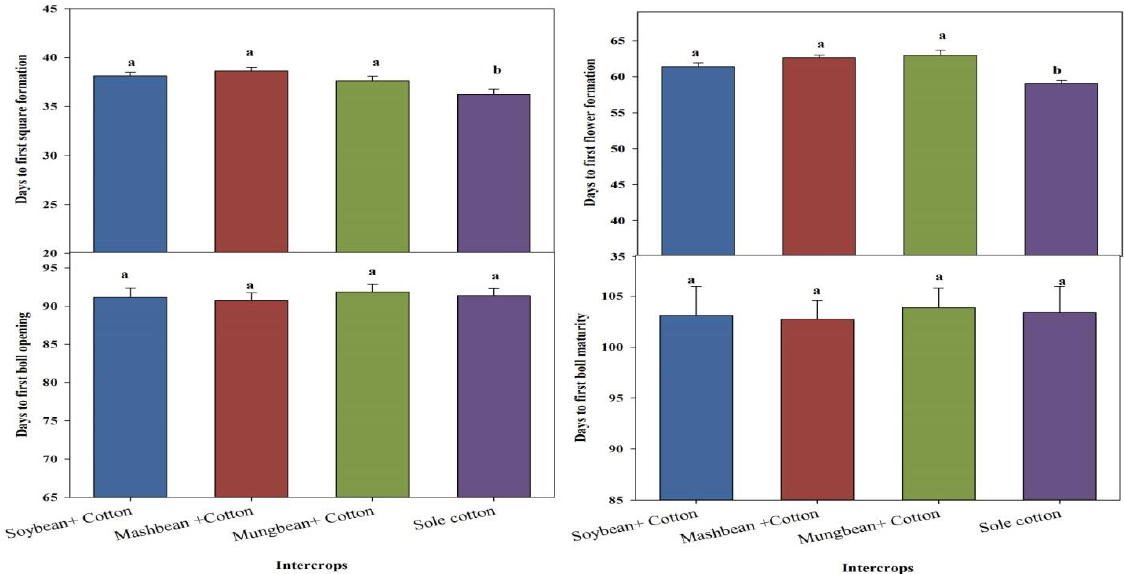
Figure 2. Effect of different legume intercrops on phenological attributes of the cotton crop under arid climatic conditions (tillage systems data are presented in Table 1, as some parameters were not significant, making them difficult to present in graph form). (Letter “a” on all graph bars showed the non-significance of the data at p ≤ 0.05. Table 1. Effect of different tillage systems on phenological, physiological, morphological, and yield- related attributes of cotton crop, and soil health indicators.